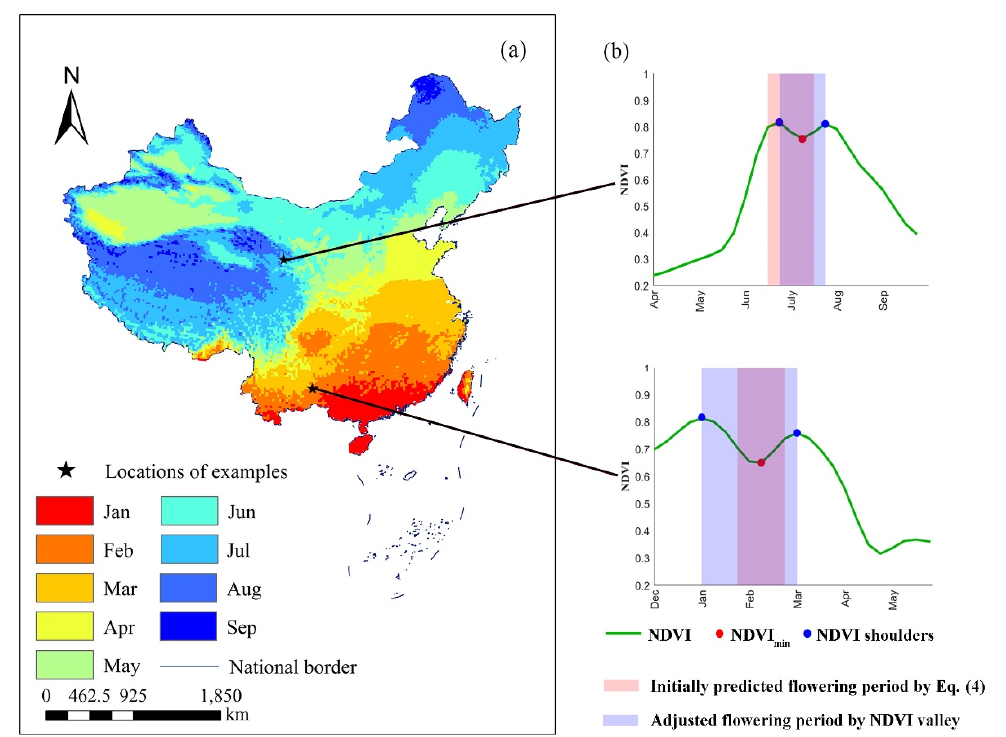
Figure 6. ( a ) Initial predicted peak flowering date by Equation (4). ( b ) Two examples illustrating how to adjust flowering period by NDVI time-series.